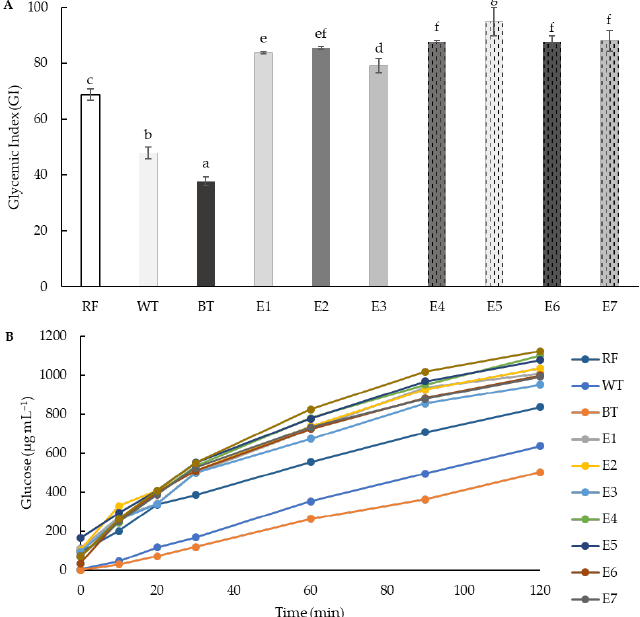
Figure 7. ( A ) Glycaemic index (GI) and ( B ) glucose kinetics consumption ( µ g mL − 1 ) of native rice (RF), white teff (WT) and brown teff (BT) flours, and extruded blend flours (E1-E7). Different letters indicate significant differences ( p < 0.05) between samples. M1/E1 (100RF), M2/E2 (12.5WTF/12.5 BTF/75RF), M3/E3 (25WTF/75RF), M4/E4 (25BTF/75RF), M5/E5 (25WTF/25 BTF/50RF), M6/E6 (50WTF/50RF), M7/E7 (50BTF/50RF).